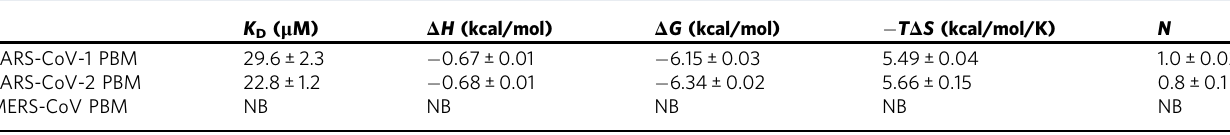
NB denotes no binding. Each of the value was calculated from at least three independent experiments. Errors are ±SD.